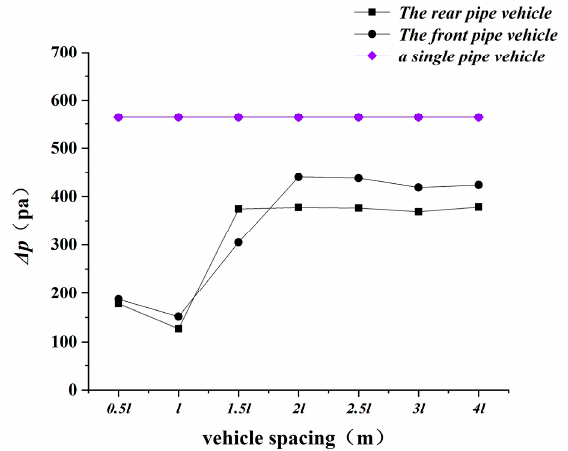
Figure 14. Pressure difference between front and rear pipe vehicles under different spacings.